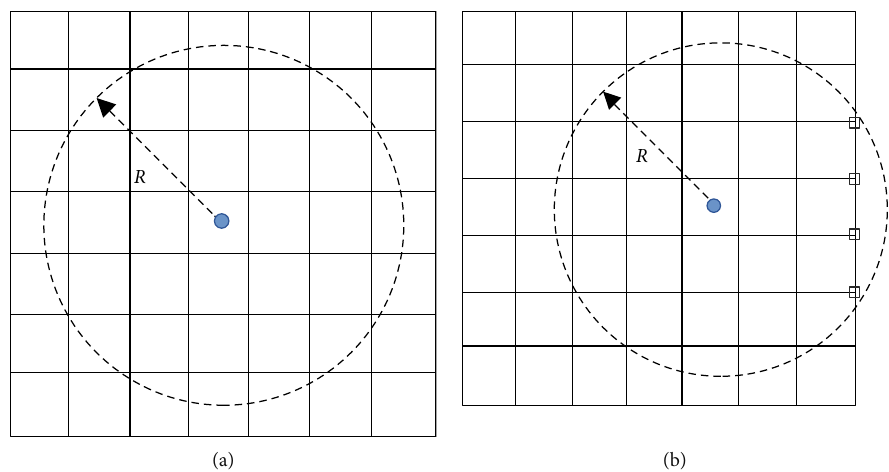
Figure 6: Zone of integration around a tip for IMM: (a) zone inside the domain; (b) zone outside the domain.